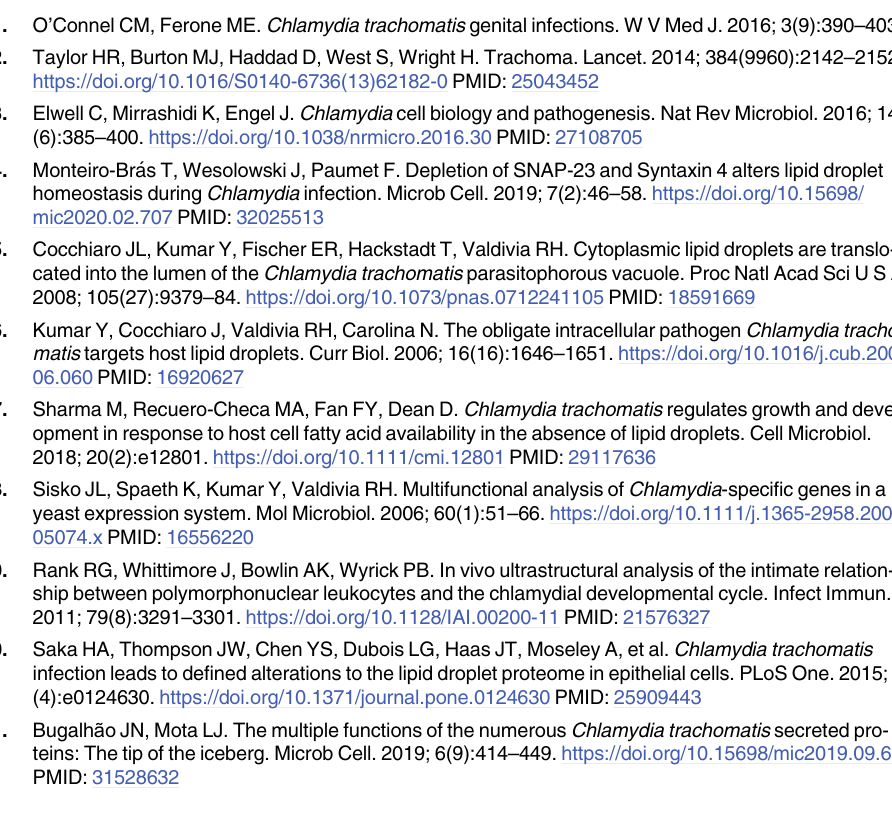
S5 Table. Oligonucleotides used in this work.